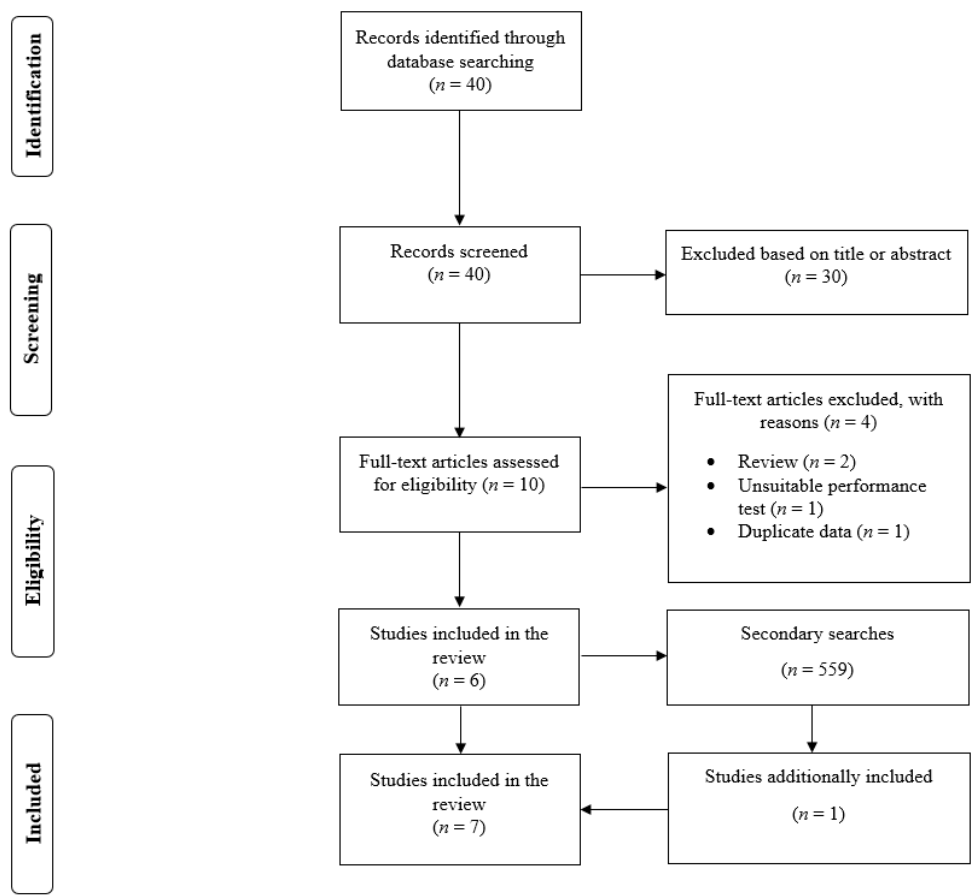
Figure 1. Flow diagram of the search process.